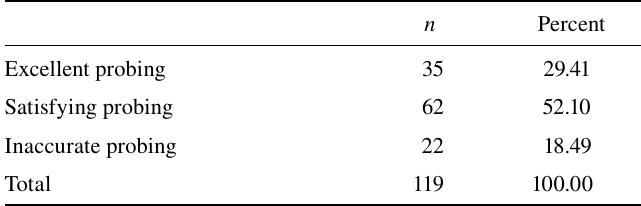
Interviewer behavior regarding probing